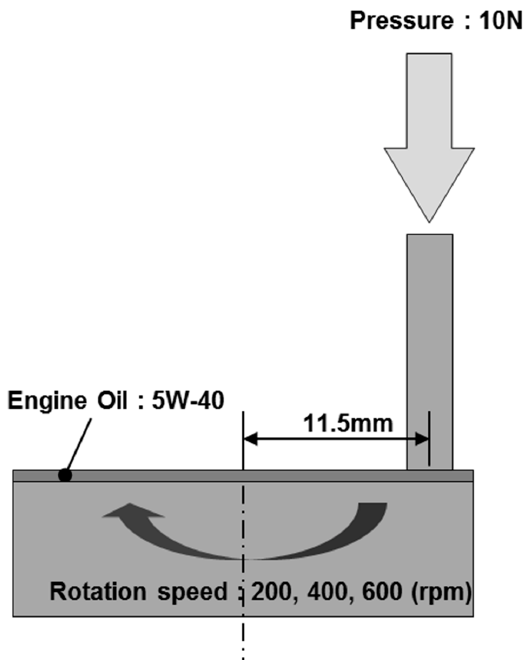
Figure 9. Schematic diagram of the experimental friction test.